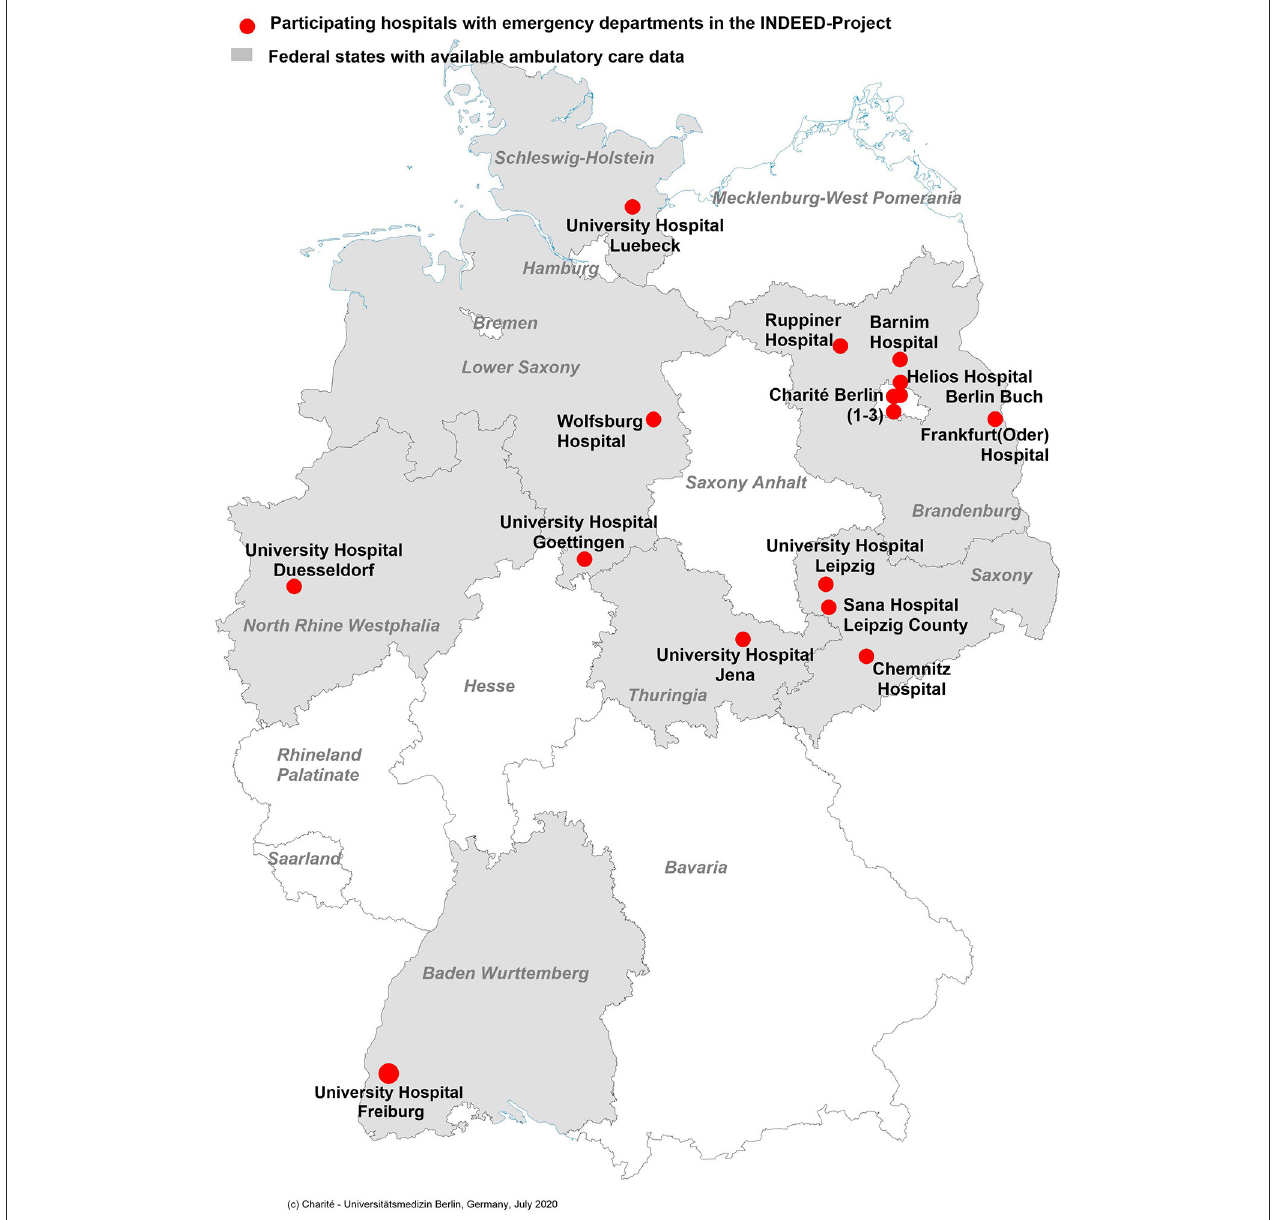
FIGURE 2 | Overview of the 16 participating hospitals with emergency departments (red dots) and the German federal states (in gray) where the regional Associations of Statutory Health Insurance Physicians provided outpatient health care data. “Charité Berlin (1–3)” designated 1 = Campus Virchow Klinikum, 2 = Campus Mitte, 3 = Campus Benjamin